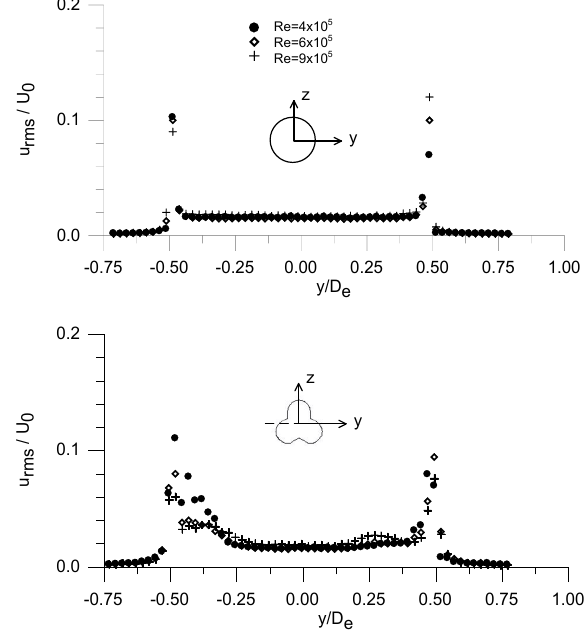
Fig. 5. Turbulence intensity profiles at x/De=0.1 Comparison of velocity contours at same downstream locations (x/De) show that the effective area occupied by the jet flow at the same downstream locations is increased by the lobed geometry. This result indicates higher spreading rates and enhanced mixing in lobed